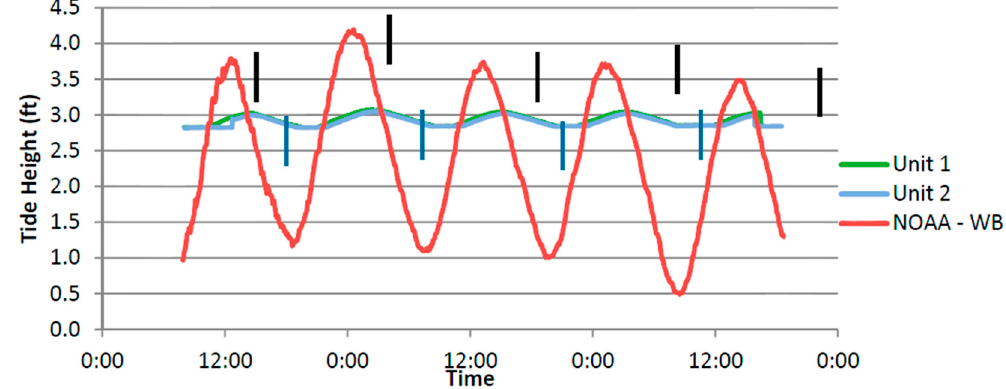
Figure A1. Tide heights for the pressure transducers and NOAA tide gauge.